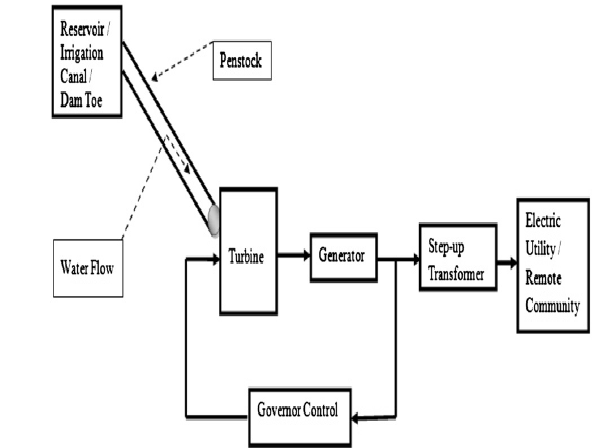
Fig. 2. Block Diagram showing different sections of a small Hydropower Station To determine the flowing water potential, it is compulsory to calculate the head and flow rate (Q s